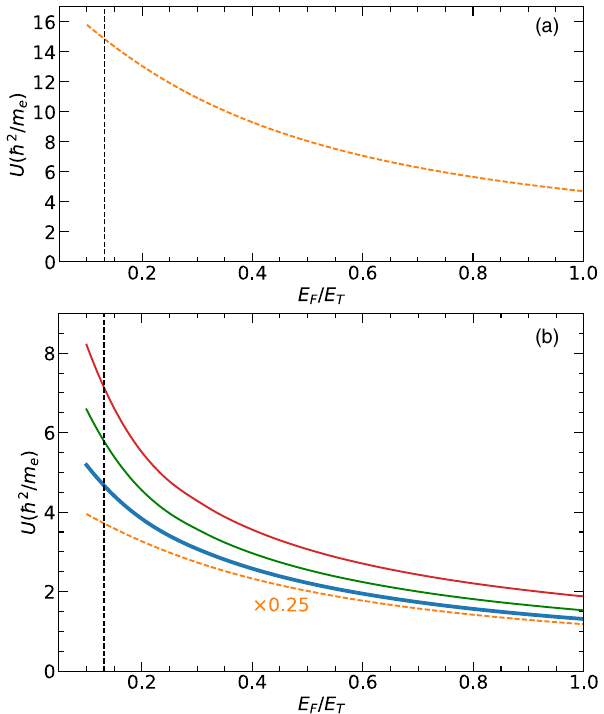
FIG. 5. (a) Interaction strength of exciton-polarons in the absence of cavity coupling. The black dashed line is a guide to the eye to illustrate the Fermi energy probed experimentally, i.e., ¼ 3 . 3 = 25 . (b) Residual interactions between polaron- E =E F T polaritons. The thicker blue line denotes the interactions of Fermi polaron-polaritons as a function of Fermi energy when Ω ¼ 0 . 2 E , corresponding to the experimental value. The green T and red solid lines correspond to Ω ¼ 0 . 5 E and Ω ¼ 1 E , T T respectively. For this plot we choose the detuning of the cavity Δ ¼ E þ Ω 2 =E , where E 0 denotes the energy of the attractive 0 T exciton-polaron, to ensure that the polaron-polariton normal- mode splitting vanishes at zero Fermi energy. The interaction strength of exciton-polarons (scaled by a factor of 0.25) in the absence of cavity coupling has been replotted here for com- parison. The enhancement of interactions with increasing cavity-polaron coupling Ω is evident. The black dashed line is a guide to the eye to illustrate the Fermi energy probed ¼ 3 . 3 = 25 . Energies are in units =E experimentally, i.e., E F T of ℏ 2 =m e